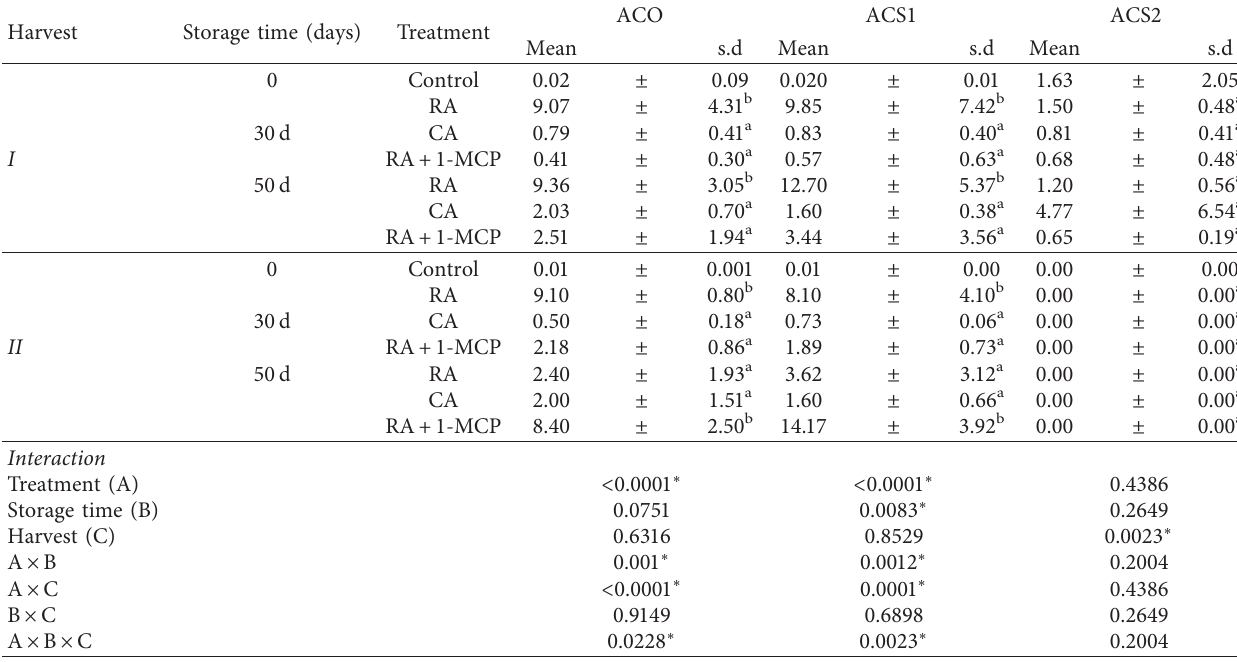
Table 4: Gene expression analysis of PamACO , PamACS1 , and PamACS2 transcript in “Fuerte” avocado under different storage conditions for 30 and 50 days at 5 ° C. Fruit was harvested at two maturity stages.